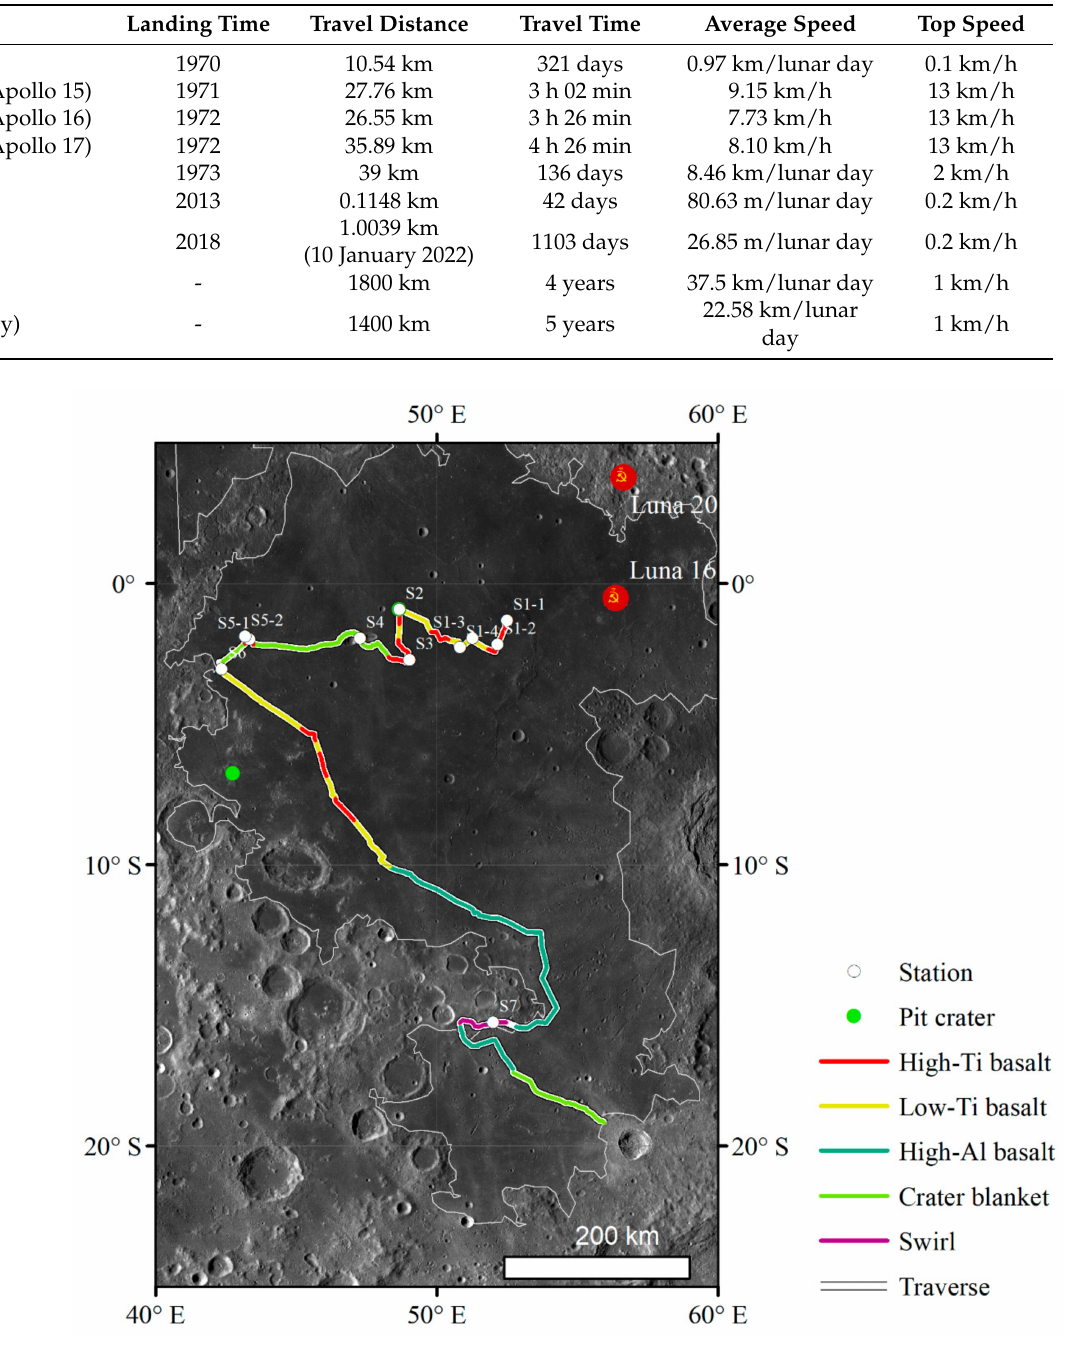
Figure 15. Long-distance detection traverse in Mare Fecunditatis, shown with a WAC image. White points represent the stations in the mission, green points represent the pit craters, and lines with different colors represent segments of the traverse. Considering the error of remote sensing data, in this figure, the high-Ti basalt-traverses are defined as TiO 2 > 5 wt% on the WAC TiO 2 map, and high-Al basalt-traverses are defined as Al 2 O 3 > 13 wt% on the IIM chemical